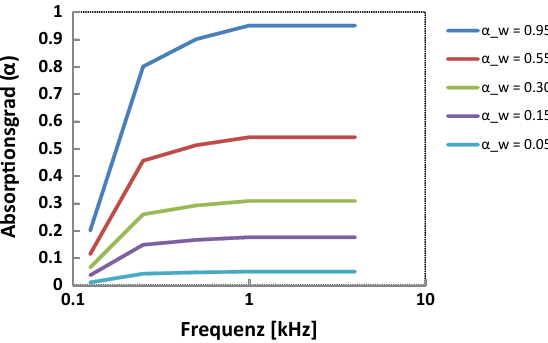
Figure 6. Absorption coefficient as a function of frequency (logarithmic horizontal